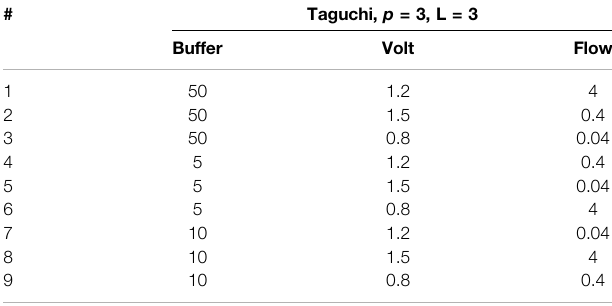
TABLE 1 | Taguchi experimental array detailing the experimental conditions and order of